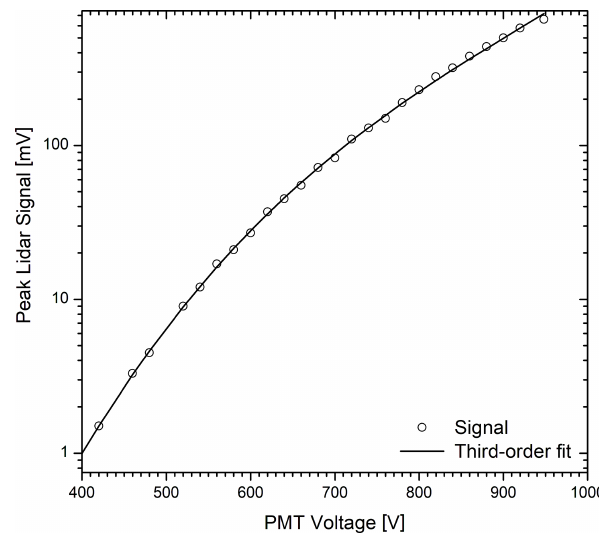
Figure 10. Peak lidar signal measured with an R7400P-03 PMT as a function of the supply high voltage. The measurement was made for different attenuations of the incoming radiation by calibrating the data to the results for the standard settings. Signal-induced nonlin- earities were only observed for very high photon fluxes, for which the supply voltage had to be reduced to 450V to ensure signals be- low 100mV (Kreipl, 2006).